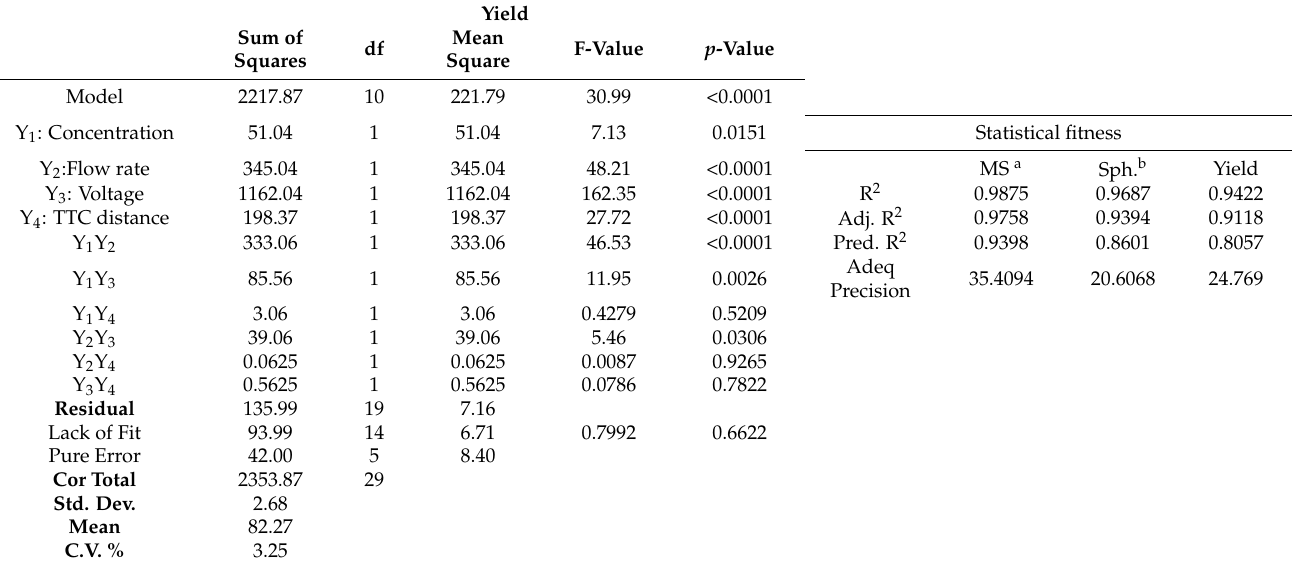
Table 4. Analysis of Variance (ANOVA) Results of Yield and Statistical Fitness Values.